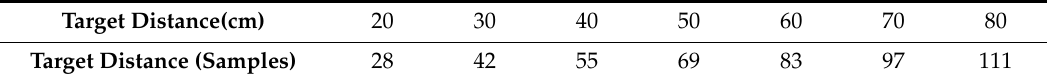
Table 1. Conversion table for target distance in samples at 25 ◦